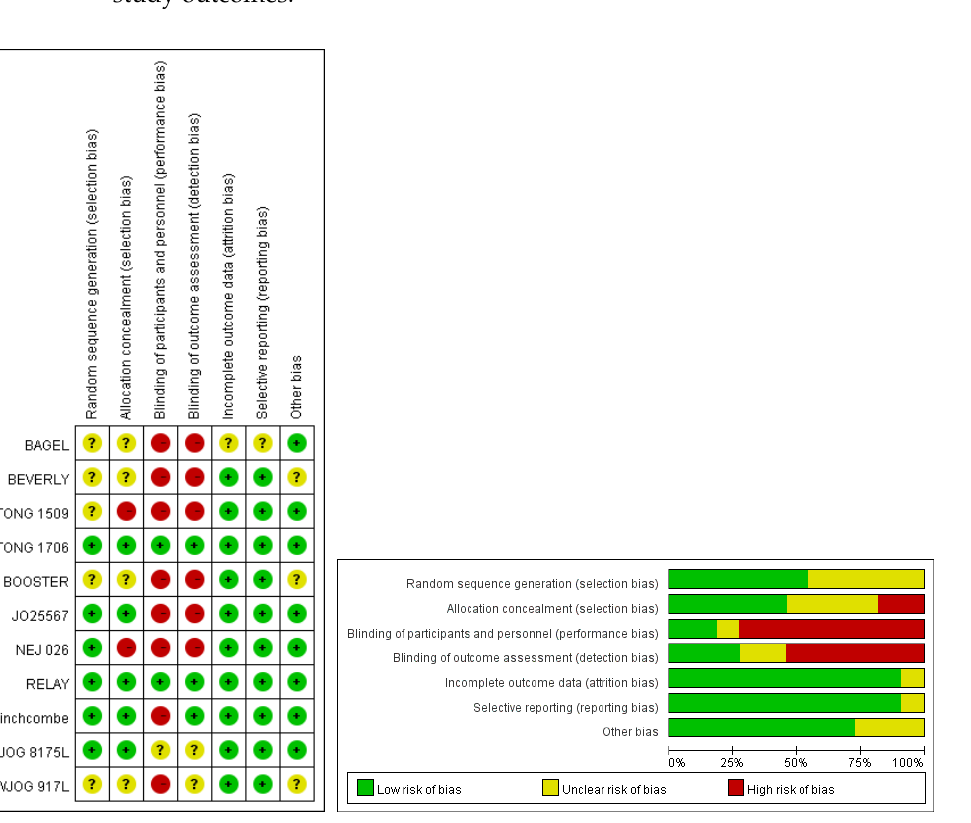
Figure 2. Risk of bias assessment.